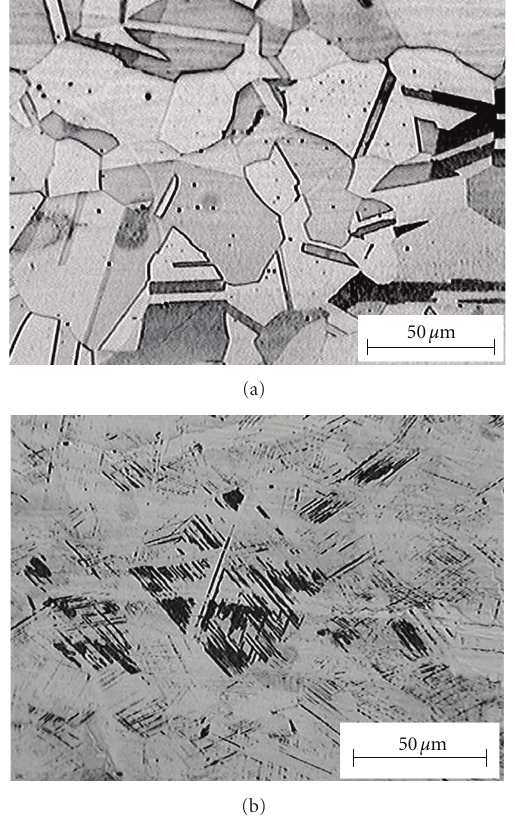
Figure 1: (a) Photomicrograph of a 304 sample as received. Etching: Glyceregia reagent. (b) Photomicrograph of a sample with true deformation of 0.03 at − 10 ◦ C. Etching: Beraha II reagent.